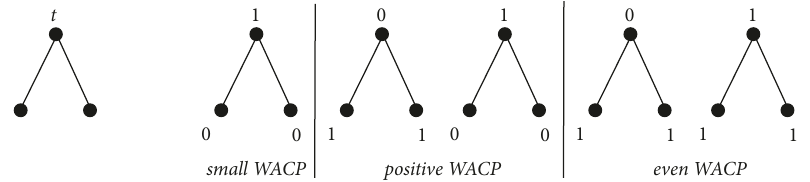
Figure 11: A little tree with root 𝑡 and its solutions to the three kinds of WACP, which show that the type of it is (1,01,01) .